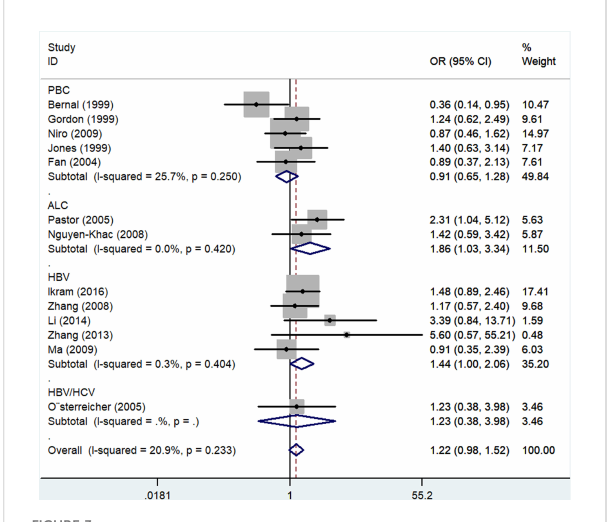
FIGURE 3 Forest plots depicting the association between rs361525 polymorphisms and LC risk in both the ALC and HBV LC subgroups generated using an allelic contrast